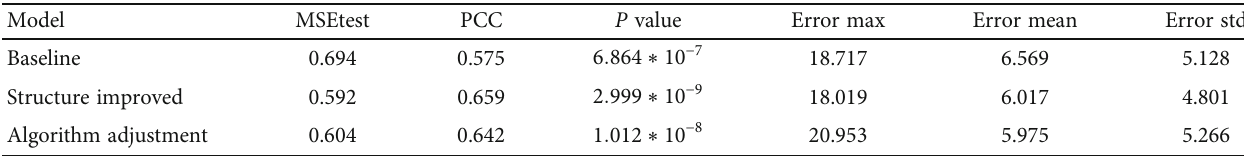
Figure 4: (a) Loss curve to every epoch, Bi-LSTM(attention adj) represent the proposed model with algorithm adjustment in attention layer. (b)Predict scores/original scores/errors to each fi les in test set(baseline).(c)Predict scores/original scores/errors to each fi les in test set(proposed). (d)Predict scores/original scores/errors to each fi les in test set(algorithm adjustment proposed). Table 2: Evaluation of 3